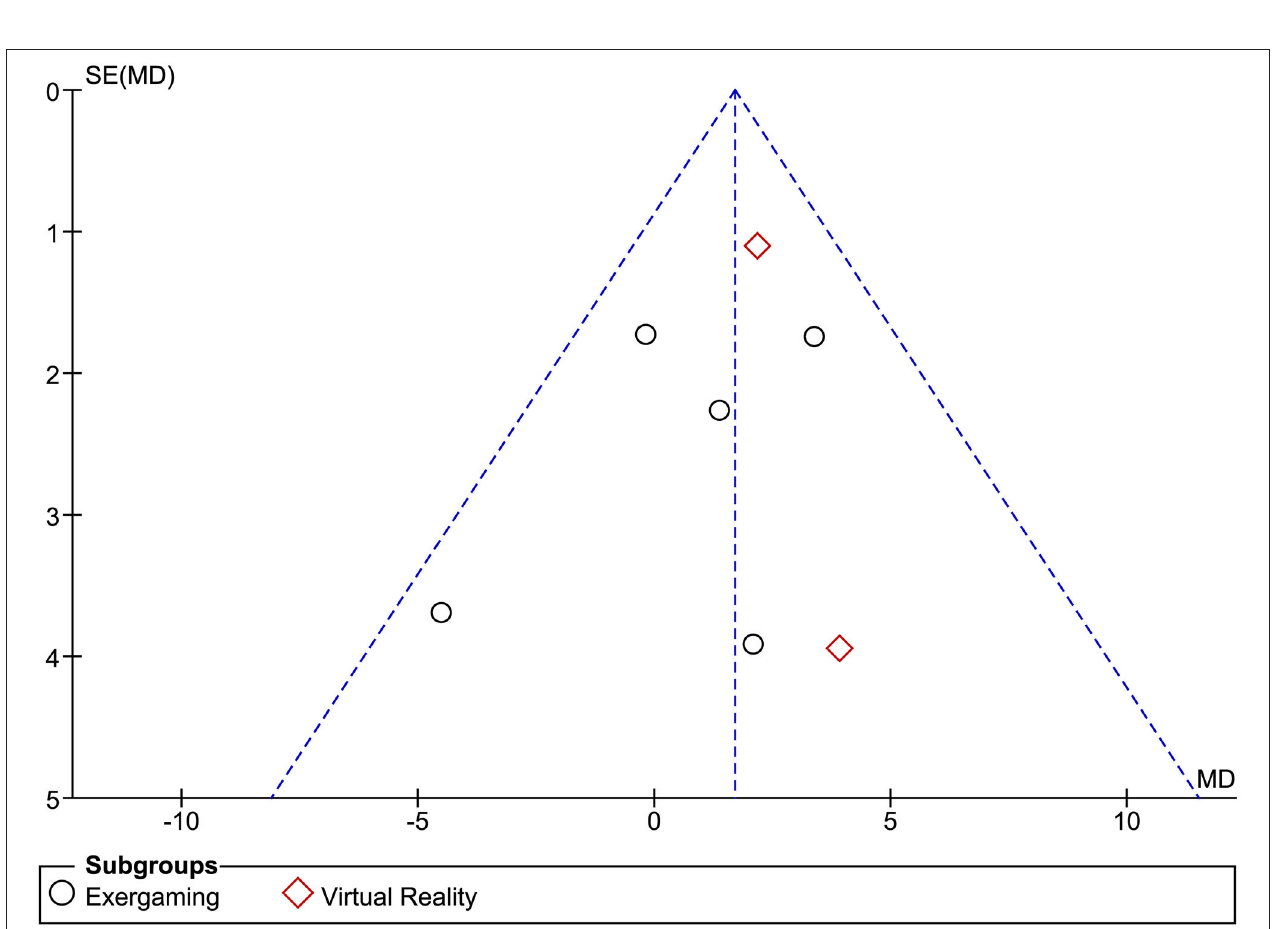
FIGURE 3 | Begg’s funnel plot analysis of publishing bias in the studies included in the present systematic review.